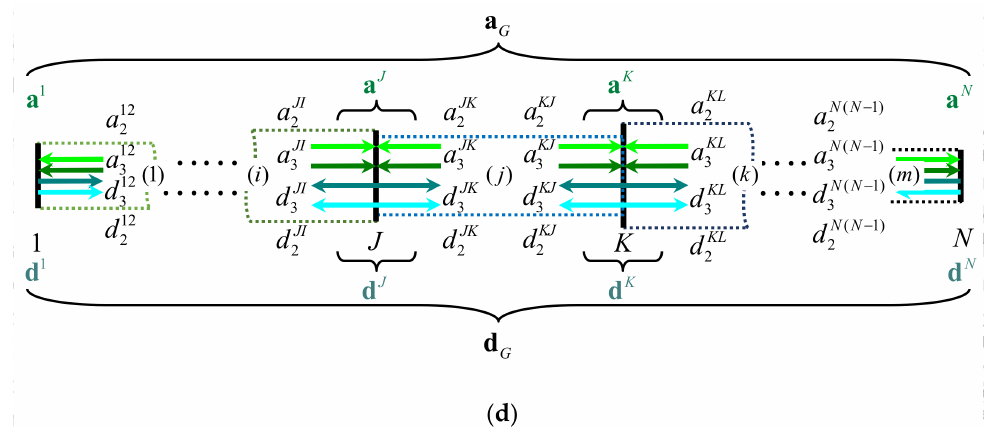
Figure 2. Description of the unit cell: the coordinates and the physical variables. ( a ) The global coordinates for joints and the local dual coordinates for structural members; ( b ) sign convention of the generalized displacements for joints and members; ( c ) sign convention of the generalized forces for joints and members; ( d ) convention of the wave amplitudes and wave